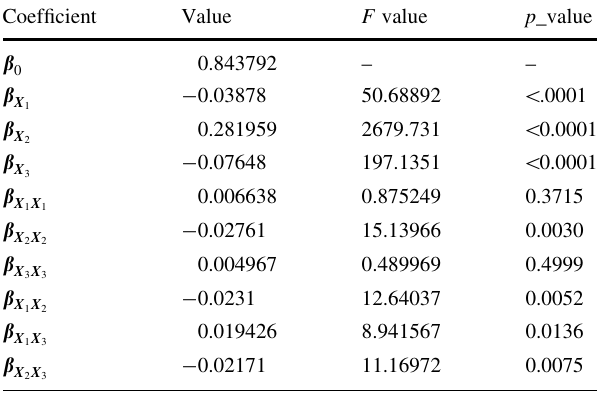
Table 3 Regression analysis of the response surface methodology (RSM) model for the viscosity of polymer solution, with the associ- ated statistical significance of each coefficient Coefficient Value